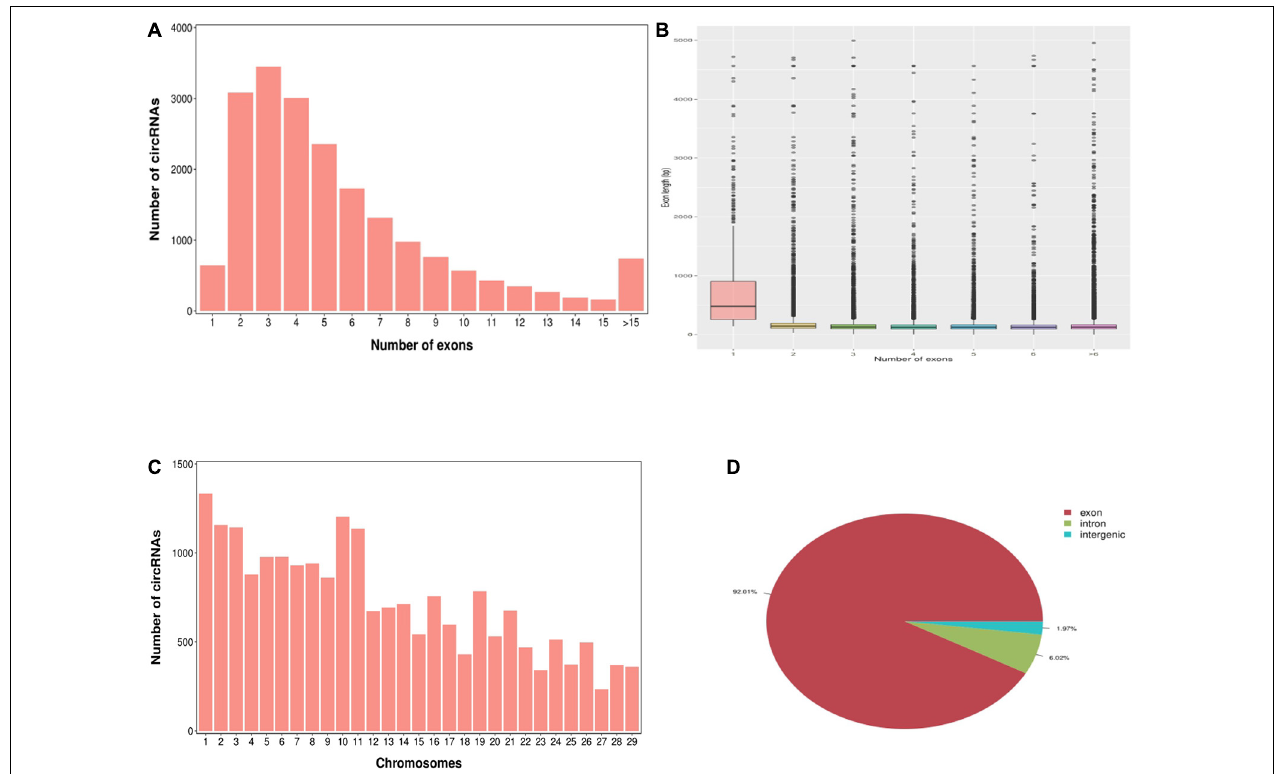
FIGURE 2 | Characteristics of circRNAs in hair follicles of cashmere goats. (A) Distribution of the number of circRNAs per gene. The x -axis represents the number of circRNAs/host gene and the y -axis represents the number of circRNA. (B) Box plot showing the exon length of exon-derived circRNAs. The x -axis represents the number of exons that the circRNA contains and the y-axis represents the exon length. (C) Distribution of the identified circRNAs in each chromosome. The x -axis represents the number of chromosomes and the y -axis represents the number of circRNAs classified by different chromosomes. (D) Classification of circRNAs in hair follicles of cashmere